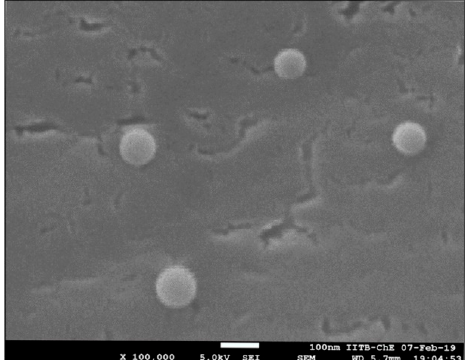
Figure 2. Cryo FEG SEM image of optimized liposome (Batch L6).